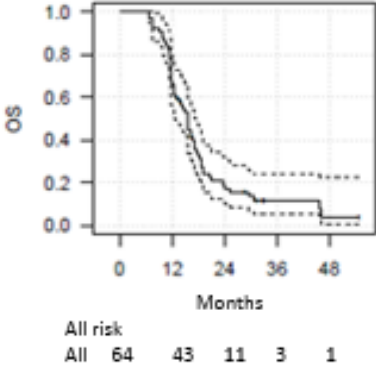
Figure 1. Overall Survival.